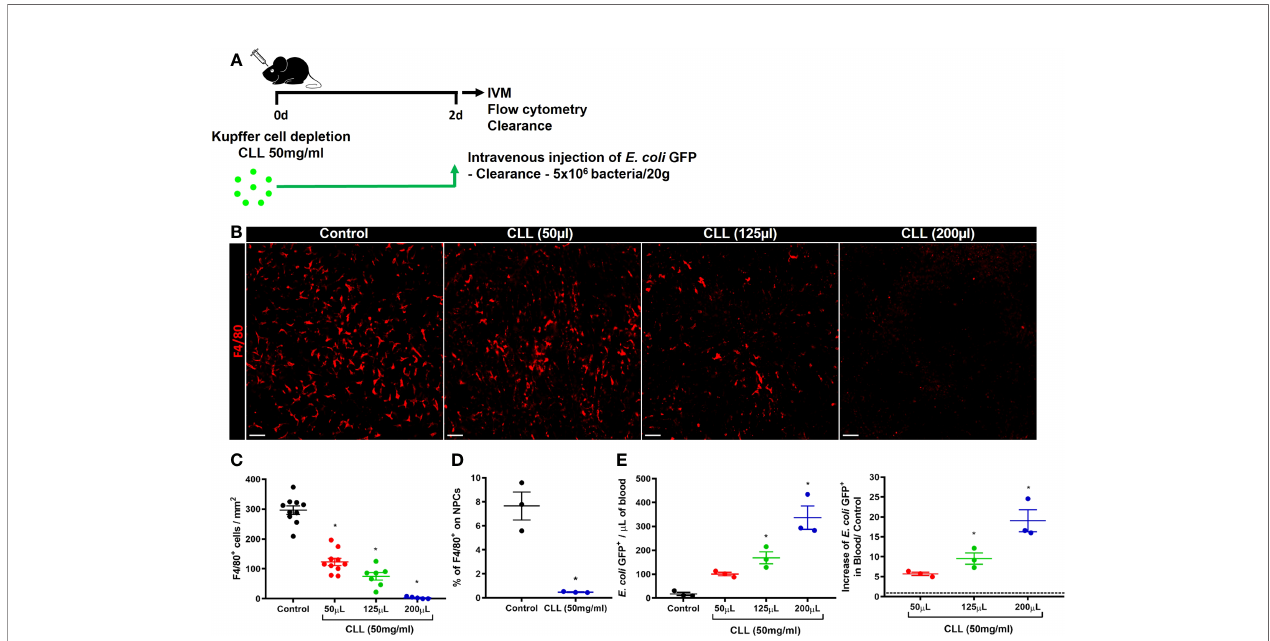
FIGURE 6 | Kupffer cells are essential for bacterial clearance and liver fi rewall function. (A) Scheme for Kupffer cell depletion using i.v injection of Clodronate Liposomes (CCL; 50mg/ml) in different volumes (50 µL, 125µL, and 200 µL). (B) Representative IVM images in mice intravenously injected with anti-F4/80 (Kupffer cells in red) 20 minutes before surgery; scale bar = 100 µm. (C) Quanti fi cation of Kupffer cells per mm 2 ; n ≥ 5 mice per group and 10 images per mice. (D) Percentage of F4/80 + cells in liver non-parenchymal cells (NPCs) measured by Flow Cytometry. n = 3 mice per group; Representative of 2 independent experiments. (E) Quanti fi cation of E. coli GFP + events from blood samples (left panel) by fl ow cytometry and determination of the blood clearance ability (right panel); n ≥ 3 mice per group; Representative of 2 independent experiments. Data are presented as mean ± SEM. * indicates statistical difference compared to the control group using T-Student test (D) and one-way ANOVA followed and Tukey post-test (C , E) (* = p <